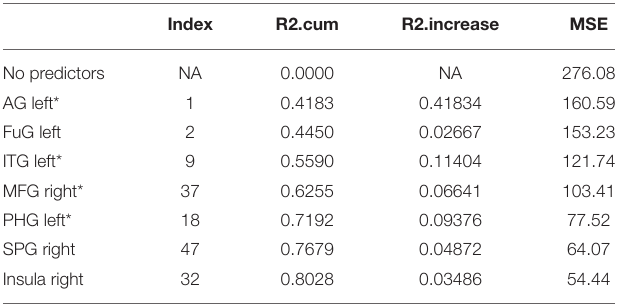
TABLE 7 | Results from a stepwise regression with the brain areas as predictors and Sum of Learning (Total RAVLT) score as the dependent